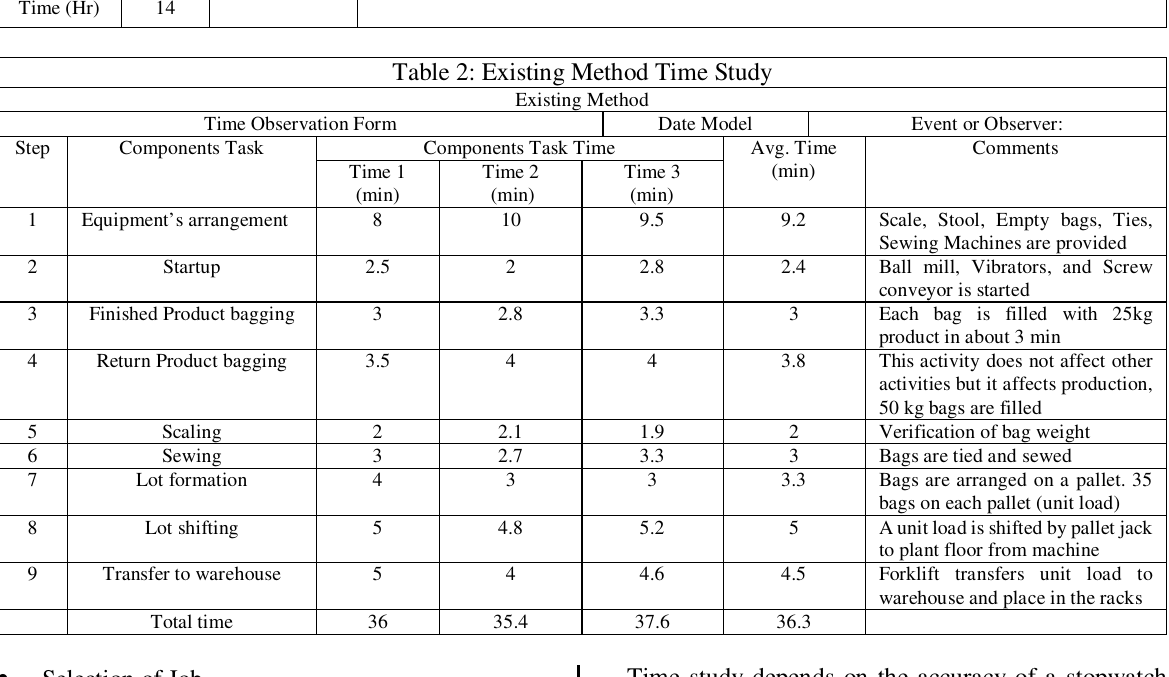
Table 2: Existing Method Time